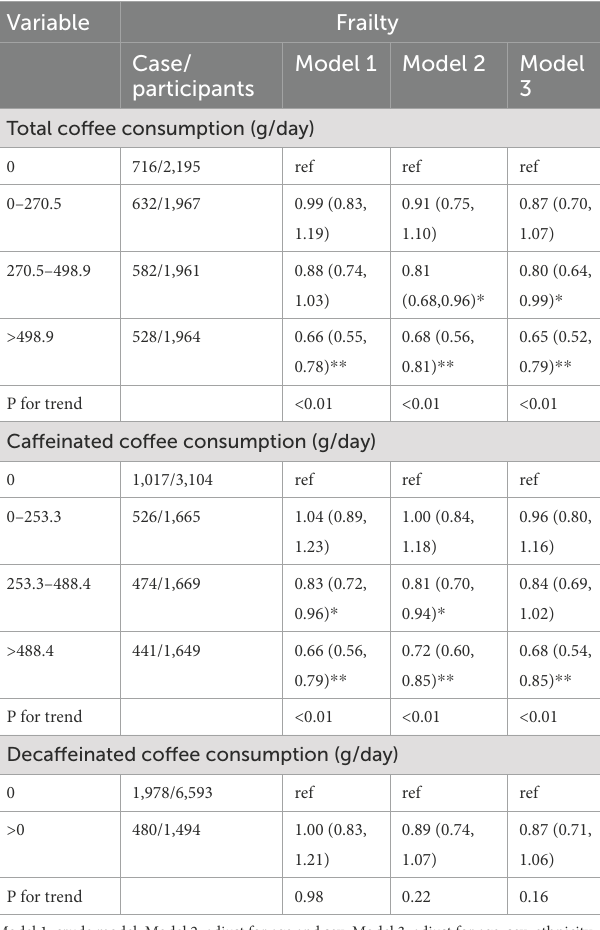
TABLE 2 Weighted odds ratios (95% confidence intervals) for the association between coffee, caffeinated coffee, and decaffeinated coffee consumption and